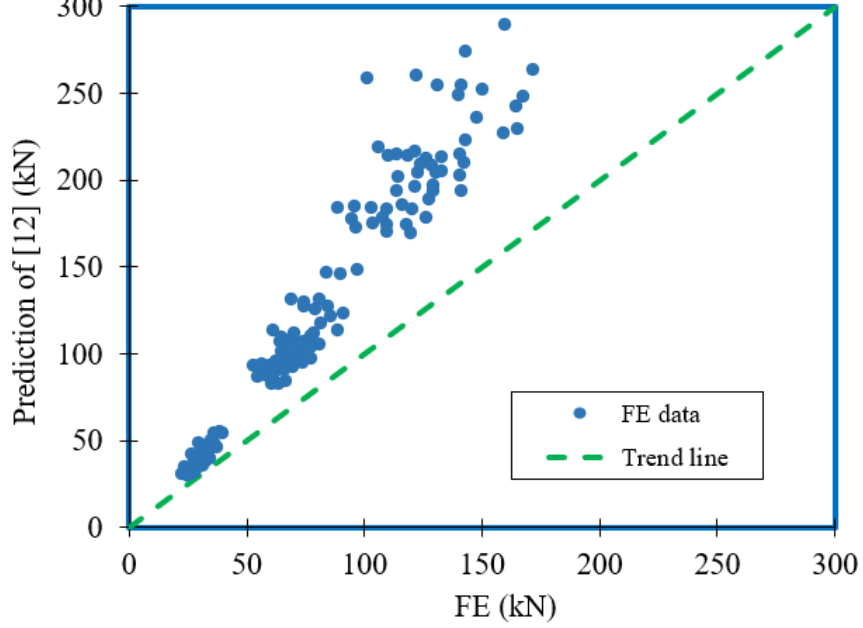
Figure 21. Comparison between parametric results and prediction of Eurocode 3 Part 1–3